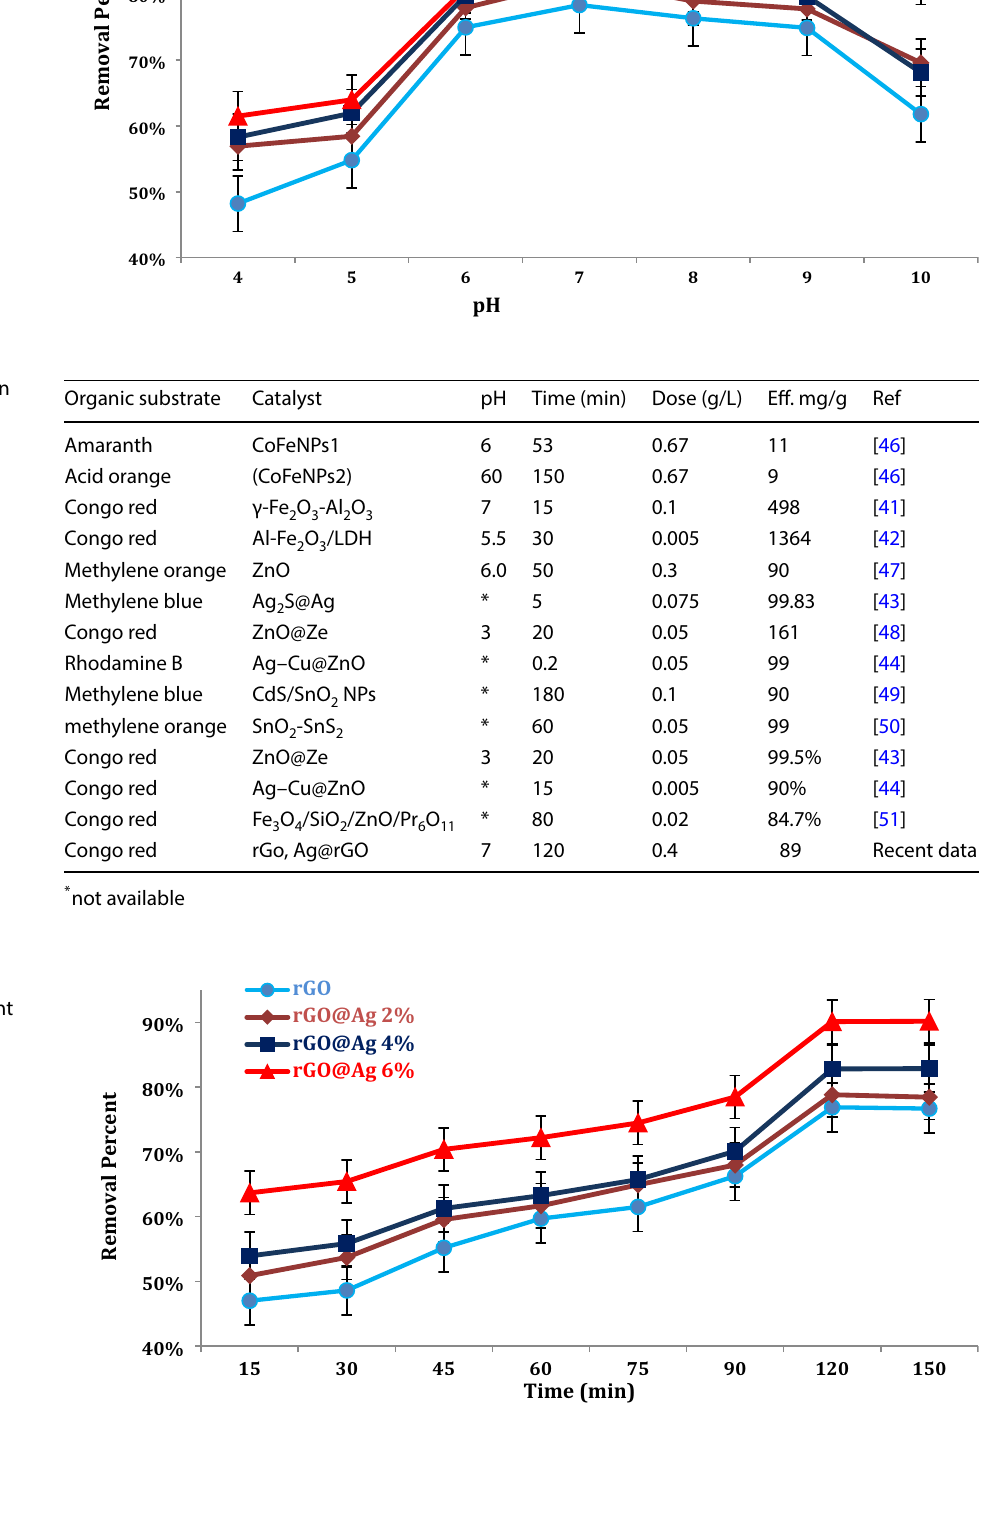
Fig. 8 Effect of solution pH on the photodegradation effi- ciency of Congo red dye under optimum conditions